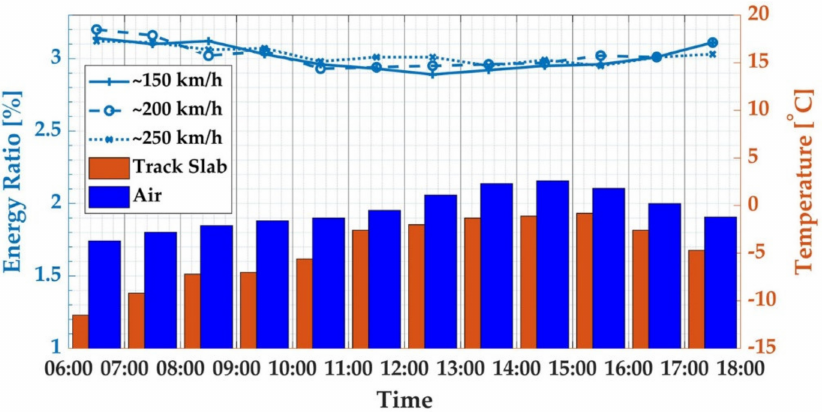
Figure 8. WPT of characteristic frequency bands for 16 January 2020,